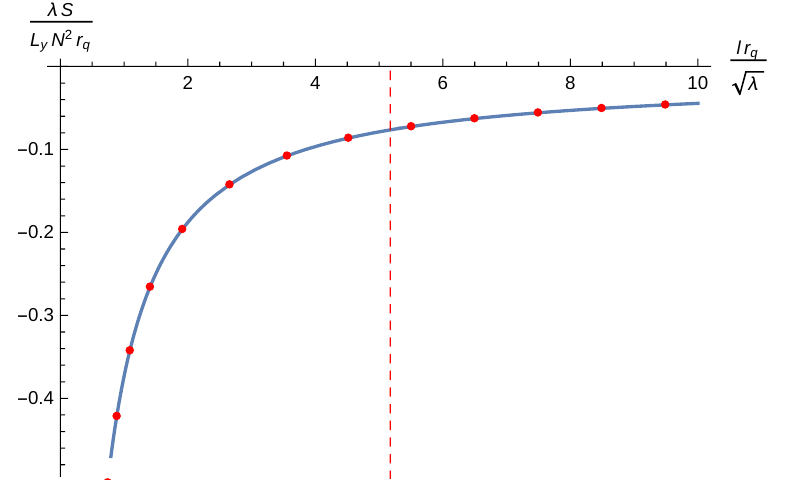
Figure 2 . Regularized entanglement entropy as a function of strip width for ^ (cid:15) = (3 = 4)( N f =N ) (cid:21) = 0 : 1. The numerical (points) and analytical (curve) results match perfectly. The vertical dashed line is the location of the